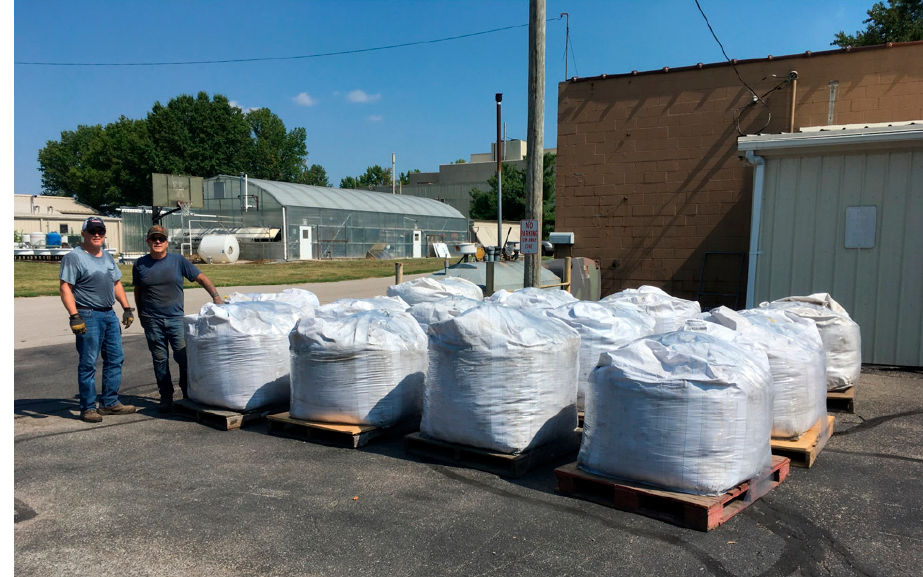
Figure 3. Thirteen bags of processed fly ash prior to their shipment for chemical processing.